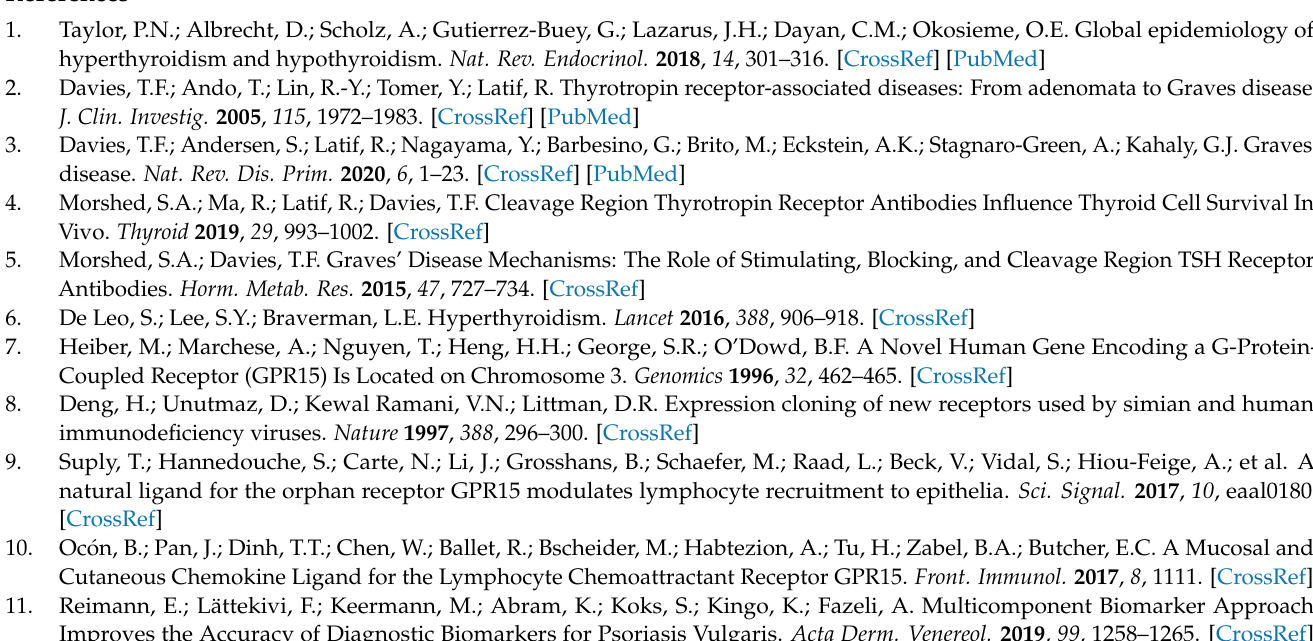
Primer sequences used in the study. Table S3: Antibodies used for flow cytometry. Table S4: Clinical characteristics of IHC subjects in this study. Figure S1: GPR15 mRNA expression was not change in Hashimoto’s thyroiditis patients. Figure S2: Frequency of GPR15+ cells among PBMCs in both groups. Figure S3: Odds ratios (OR) of the associations of GPR15+ cells frequency in PBMCs with GD after adjusting for age and